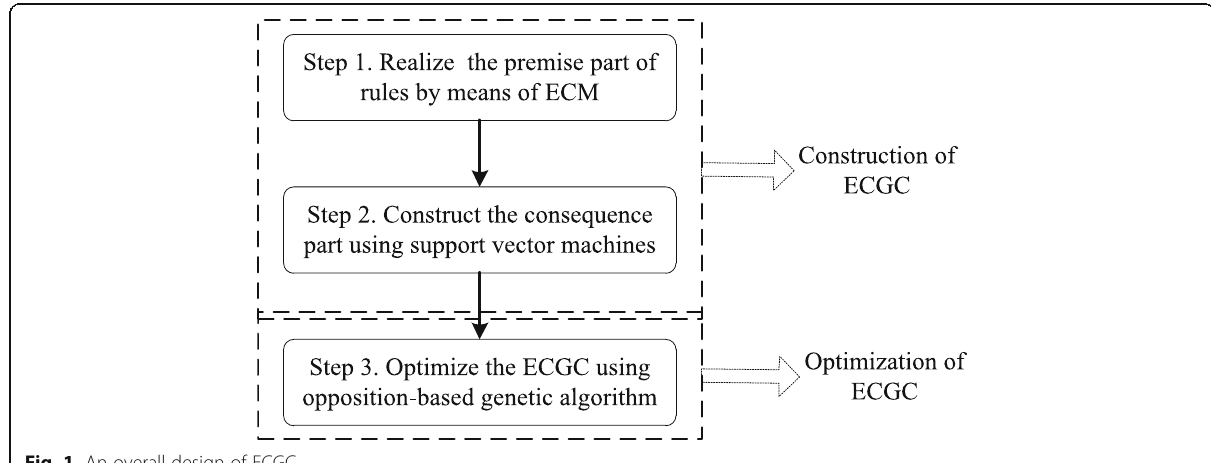
Fig. 1. An overall design of